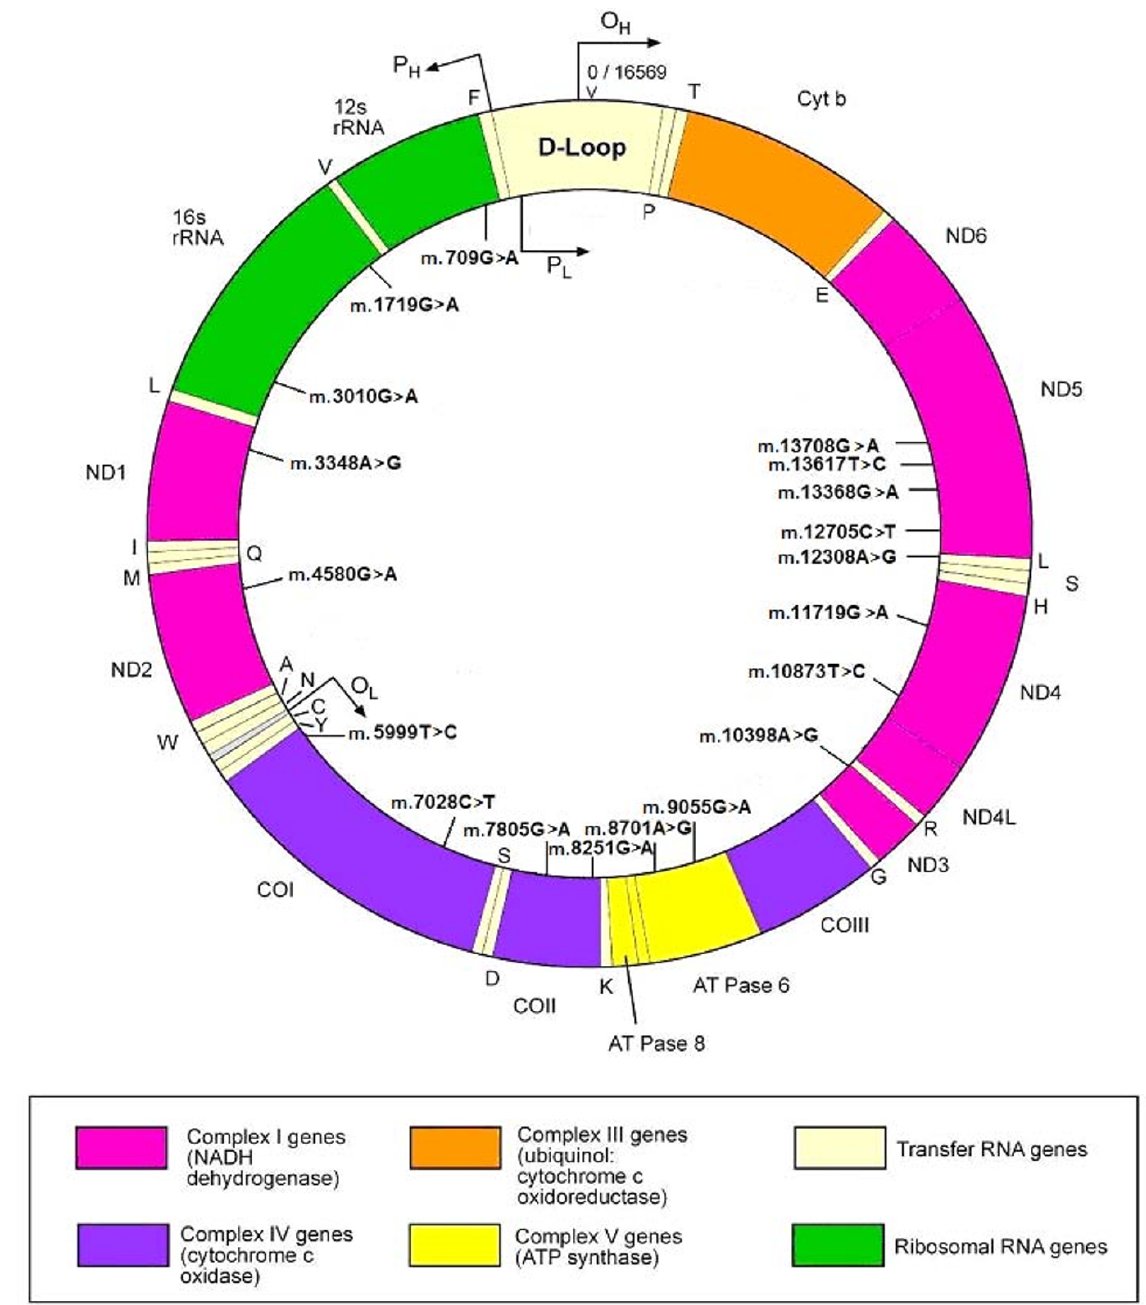
Figure 1 Genomic localization of the investigated markers within the human mitochondrial DNA molecule . The genetic location of mtDNA markers genotyped in the present study is indicated in the inner circle. H and L stand for heavy and light strands, respectively, given the asymmetric distribution of G and C nucleotides, with H being the G-rich strand. The seven complex I subunits (ND1, 2, 3, 4L, 4, 5 and 6), one complex III subunit (Cyt b), three complex IV subunits (COI, COII, and COIII), two complex V subunits (ATPases 6 and 8), two ribosomal RNAs (12S and 16S rRNAs), 22 tRNAs and D-loop regions are shown. Gene products encoded by the L-strand are shown in the inner circle (one letter code) while the products of the H-strand are shown in the outer circle. Arrows indicate the locations of promoters P tion origin O . Adapted from MITOMAP H